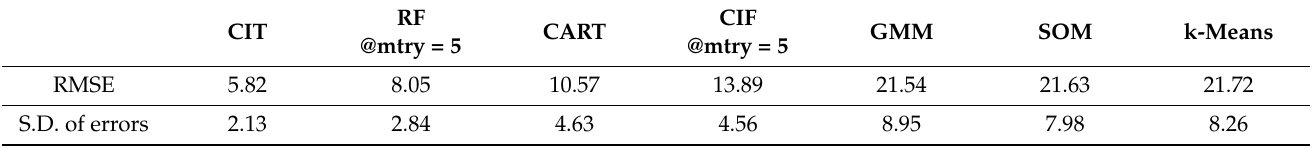
Table 8. RMSE and standard deviation of errors by